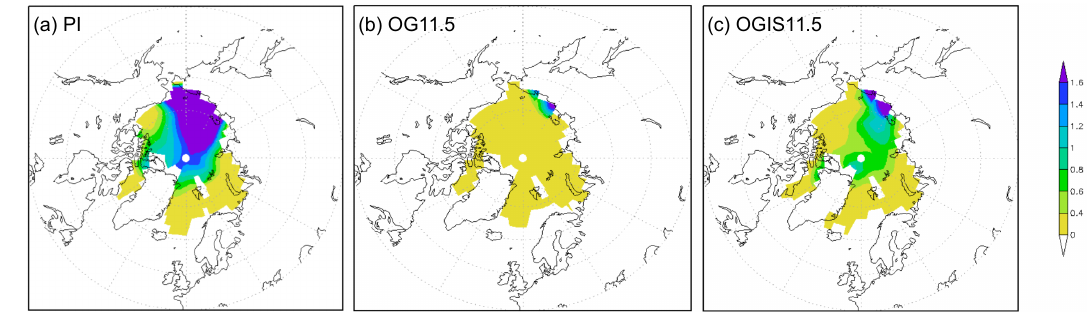
Figure 13. Minimum sea-ice thickness (m) in September for PI (a) , OG11.5 (b) and OGIS11.5 (c)